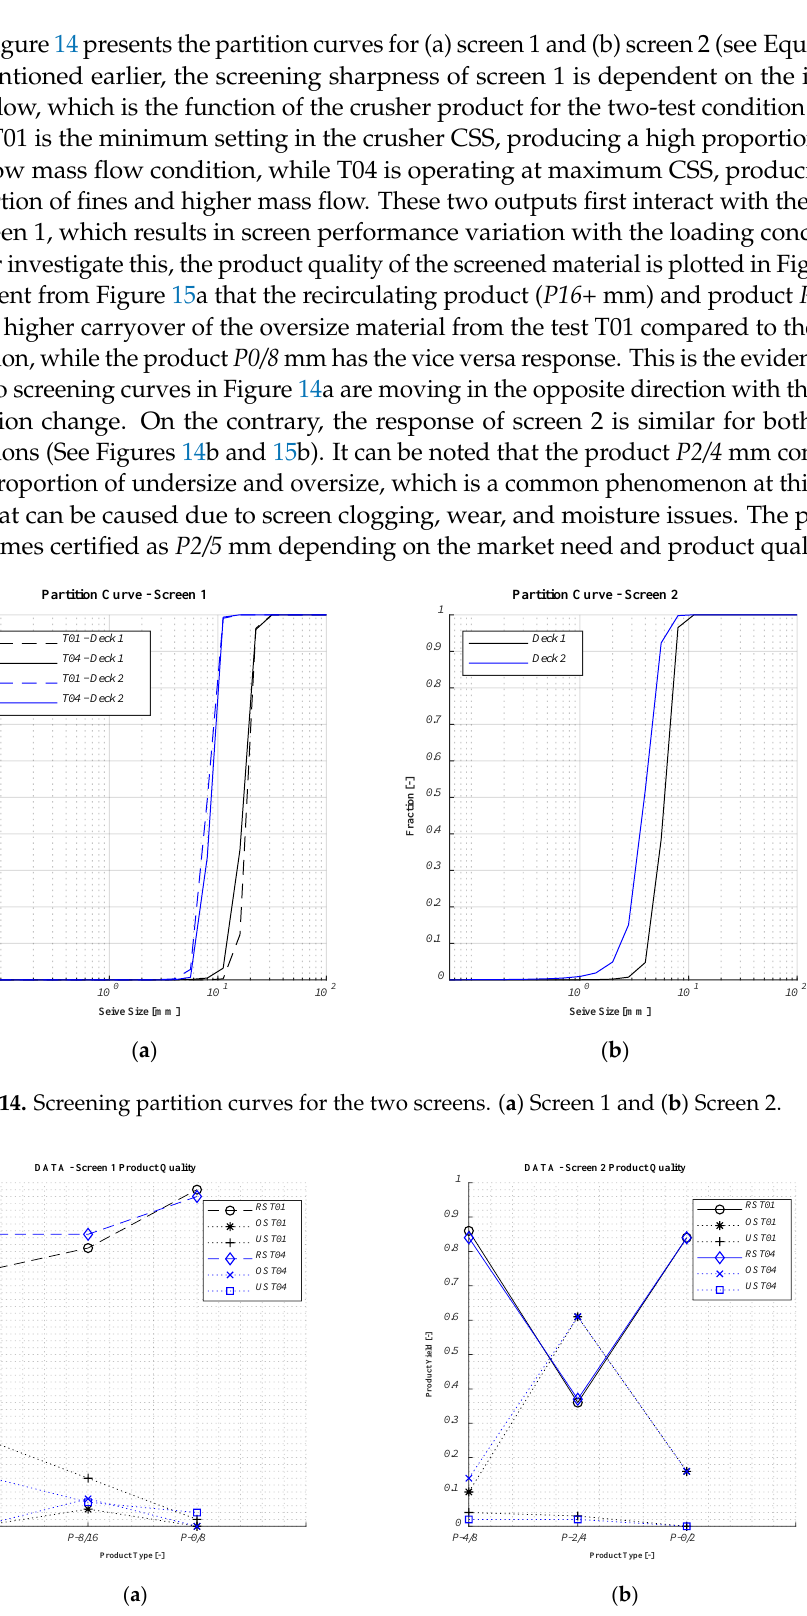
Figure 15. Product quality of the screened products at different test conditions of ( a ) screen 1, ( b ) Screen 2, where RS—Regular Size, OS—Over Size, and US—Undersize for the particular product specification.